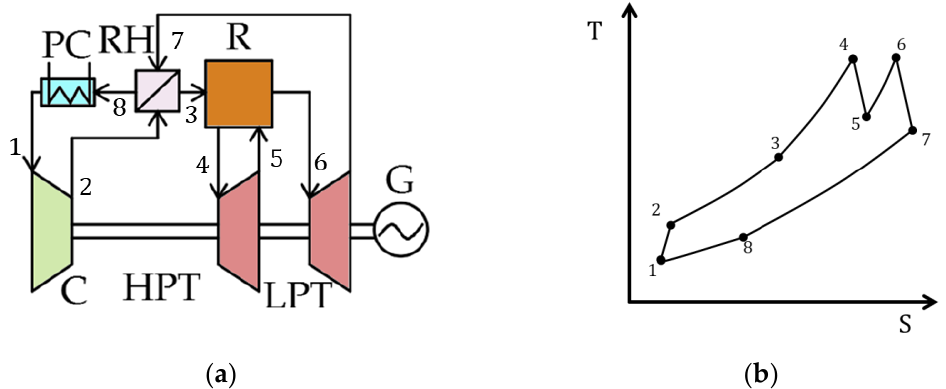
Figure 3. Supercritical CO 2 Brayton cycle with reheating: ( a ) schematic diagram; ( b ) T–S diagram [12]. R—reactor; LPT—low-pressure turbine; HPT—high-pressure turbine; G—generator; RH—regenerative heat exchanger; PC—precooler; C — compressor.